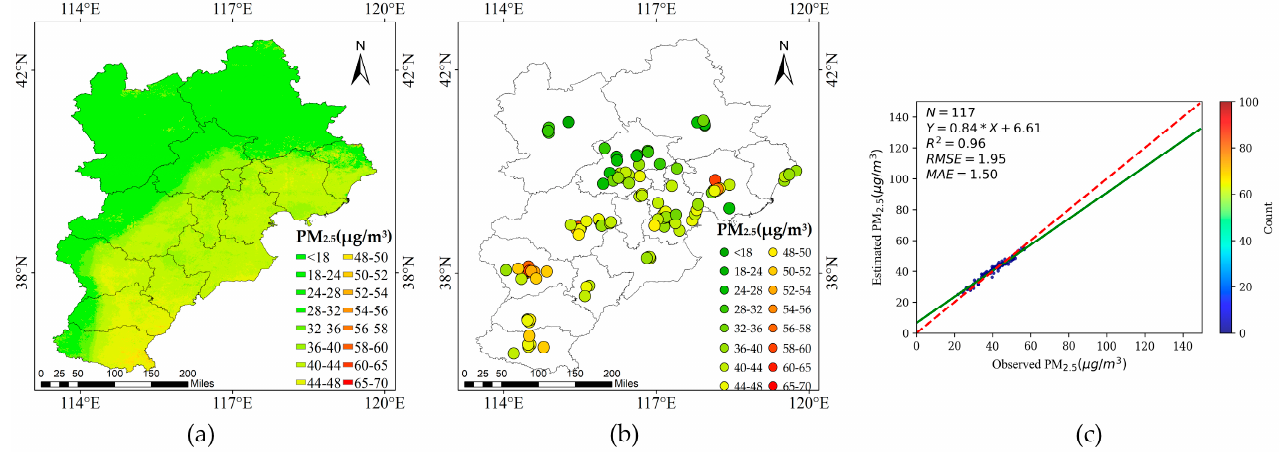
Figure 7. Spatial distributions of the annual average PM 2.5 concentrations. ( a ) NightPMES model estimates; ( b ) ground observations; ( c ) scatterplot of the ground observations versus the NightPMES model estimates.